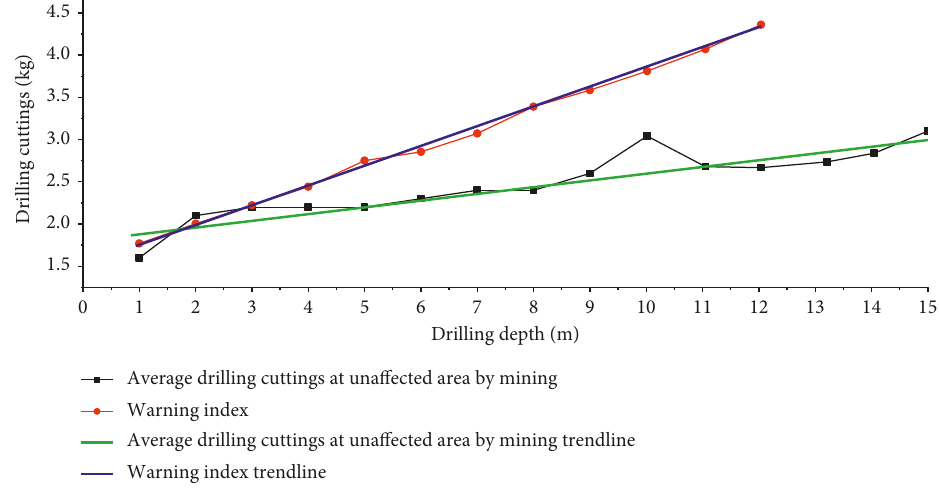
Figure 5: Drilling cutting at unaffected area by mining and drilling cutting warning index.